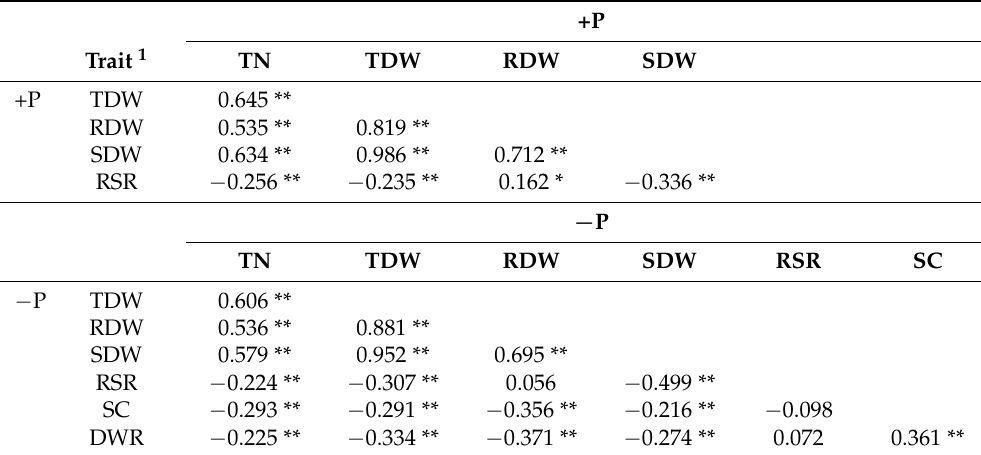
Table 2. Correlations between traits related to phosphorus (P) deficiency under +P and − P conditions using combined data from seasons 1 and 2.